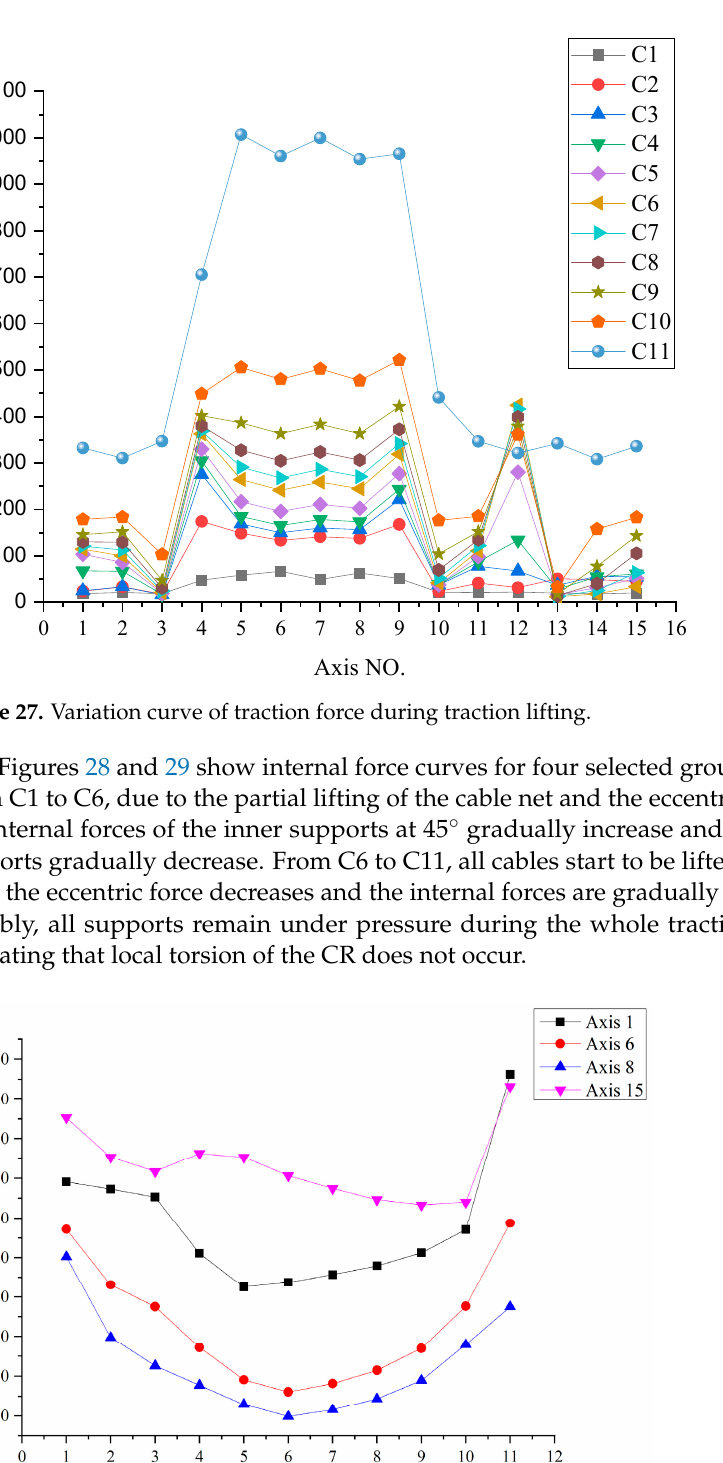
Figure 28. Internal force variation curves of four groups of typical inner CR brackets.